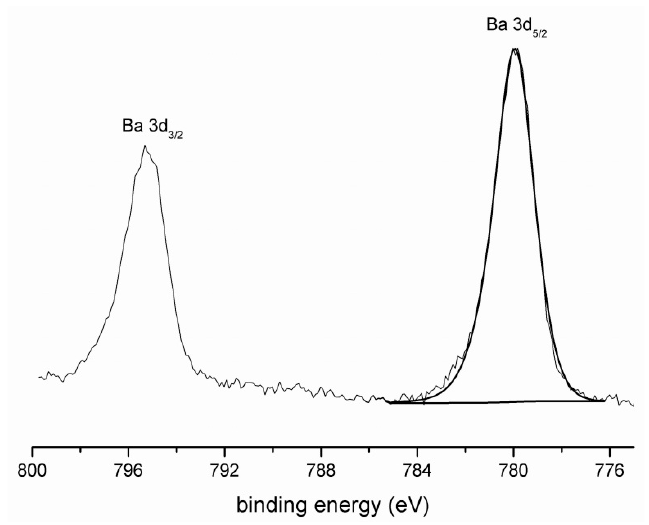
Figure 2. XPS spectrum of Ba.